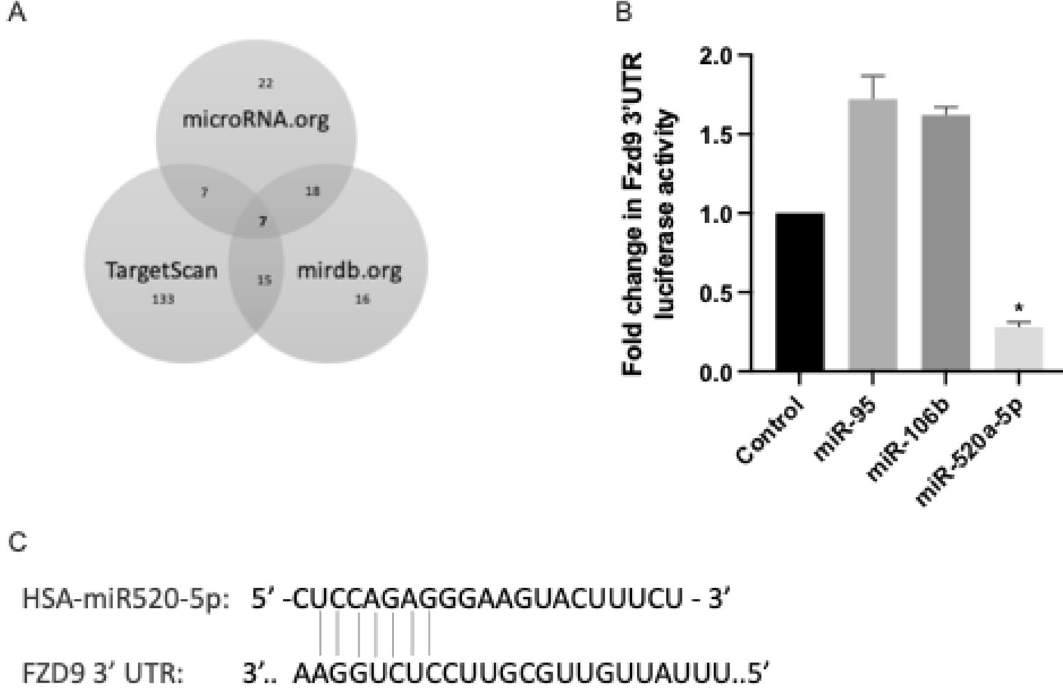
Figure 1. miRNA regulation of FZD9. ( A ) Results from database searches for miRNA predicted to target the FZD9 3’UTR. ( B ) miRNA mimics were transfected in triplicate into the A549 cell line with a FZD9 3’UTR luciferase. Luciferase activity was measured in duplicate and shown relative to control. * p < 0.05. ( C ) Alignment of miR520a-5p with the FZD9 3’UTR